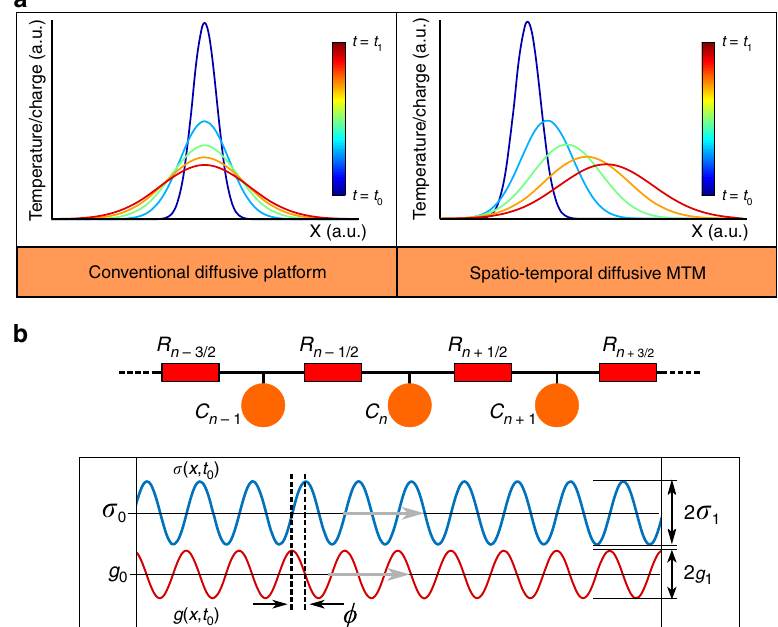
Fig. 1 Conceptual representation of controlling diffusion with metamaterial (MTM) platform. a Comparison between the time evolution of the typical diffusion process in a conventional material and in our proposed spatiotemporal metamaterial, the latter showing an effective spatial asymmetry in diffusive fl ow. b Generalized schematic representation of the metamaterial platform for periodic spatiotemporal modulation of the two governing macroscopic material properties: conductivity and capacity with a relative phase difference ϕ that controls the direction of the effective fl ow, as described in the